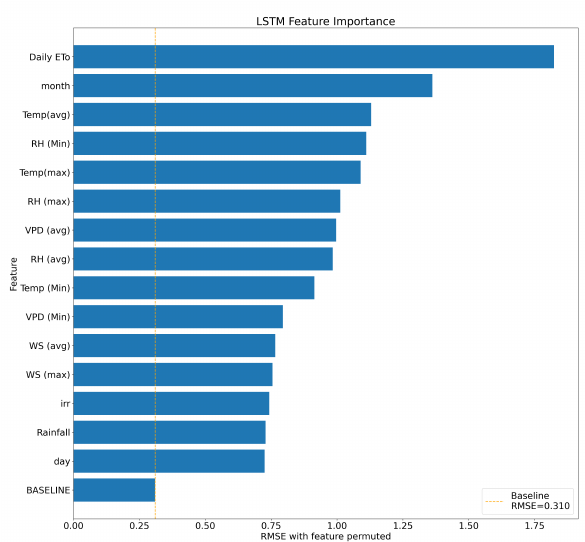
Figure 6. Feature importance using the BiLSTM model and the permutation feature importance technique.